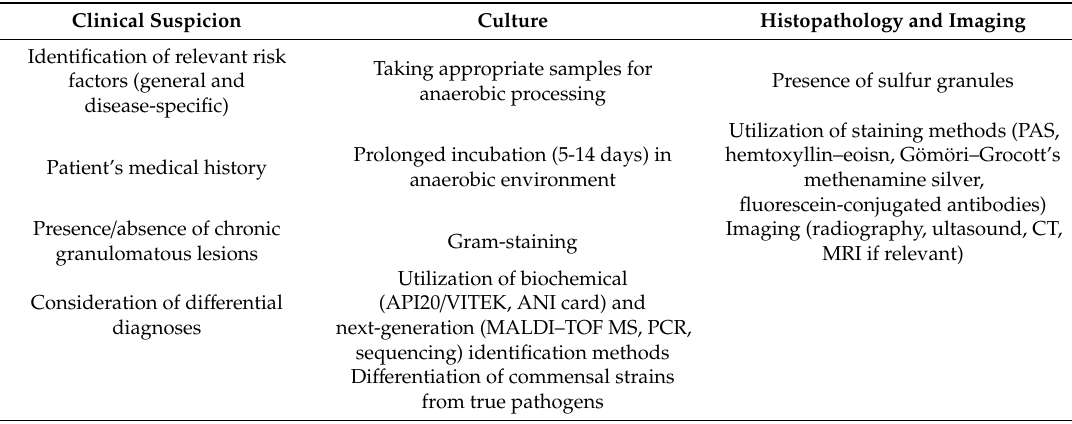
Table 2. Hallmarks of the diagnosis of cervicofacial actinomycoses (based on [8])